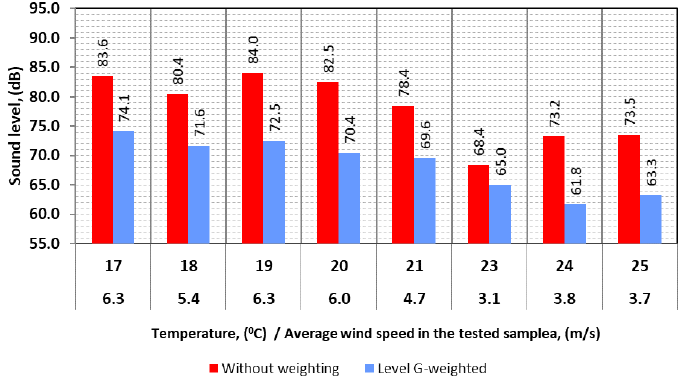
Figure 14. Variations in noise level in the function of temperature—T2 turbine.